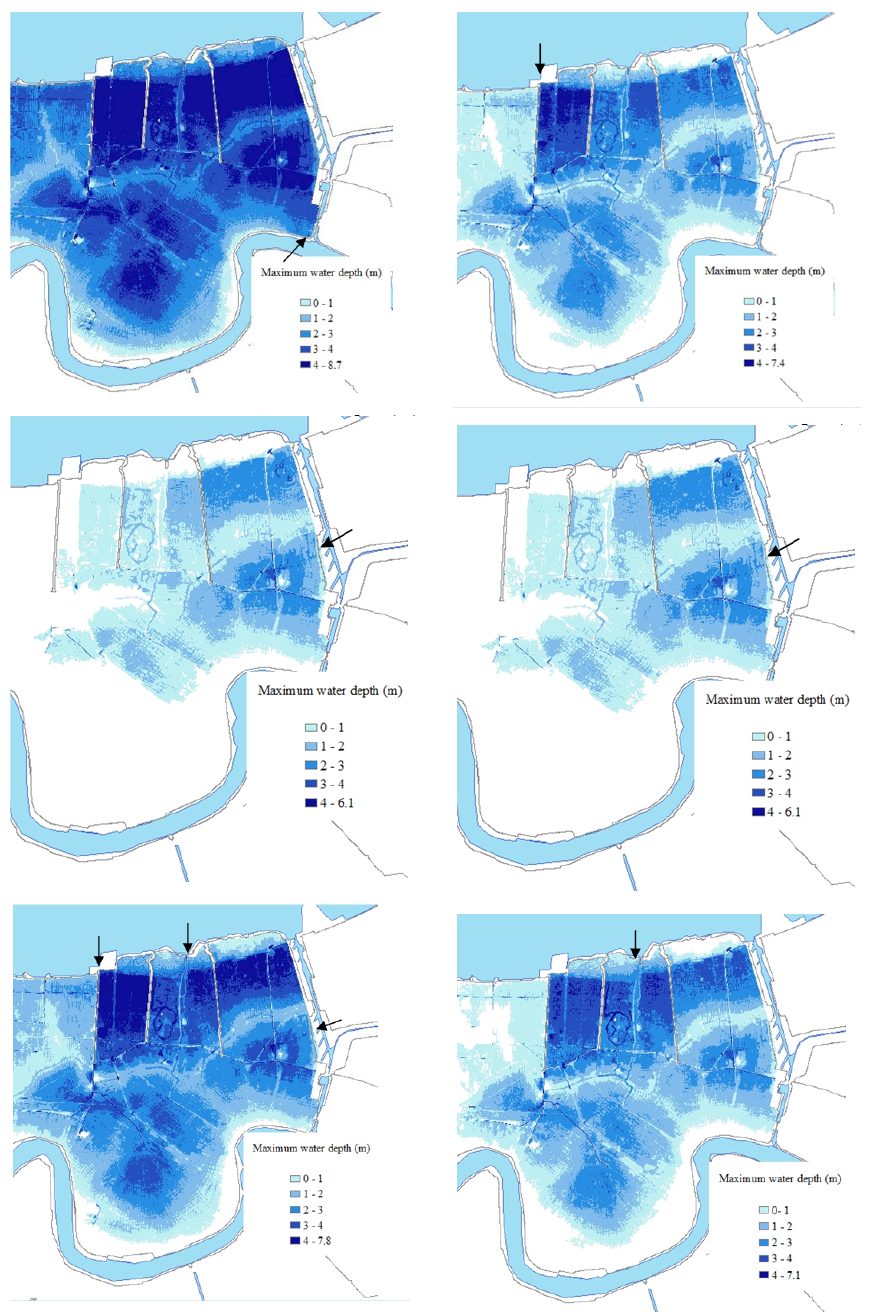
Figure 6. Maximum water depth for the various breach scenarios for the New Orleans metro bowl. Arrows depict breach